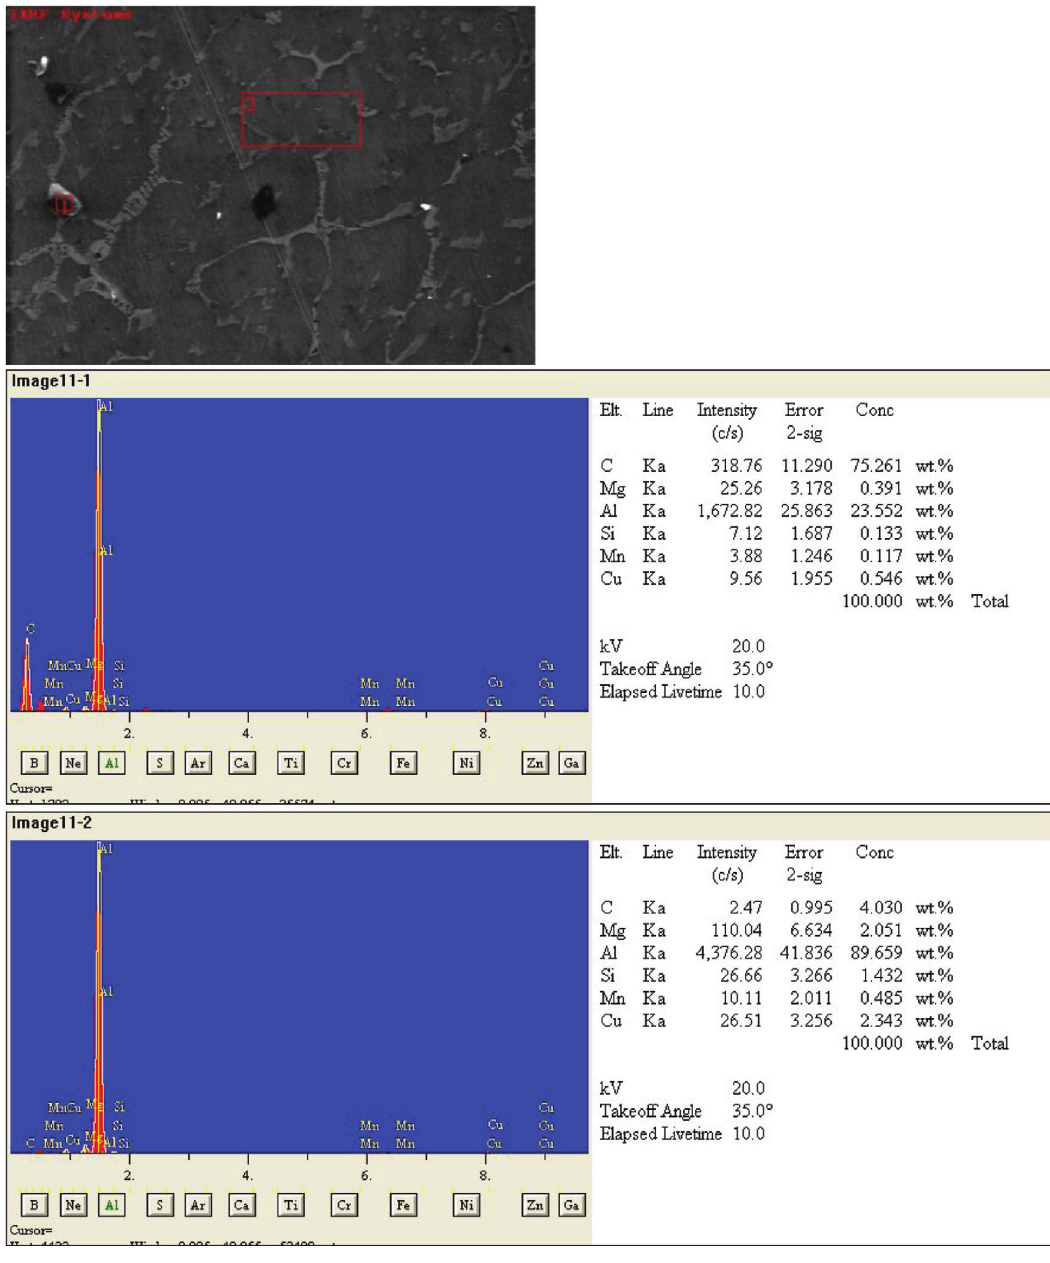
Fig. 7: EDS analyses of the 6% SiC reinforced